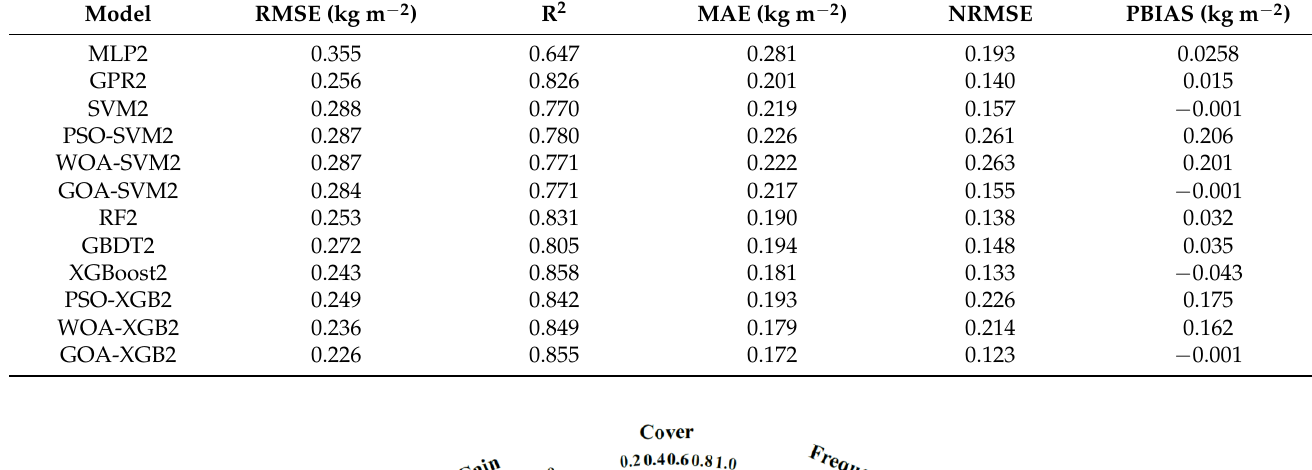
Table 7. Statistics indicators of twelve ML models with optimized features as input.